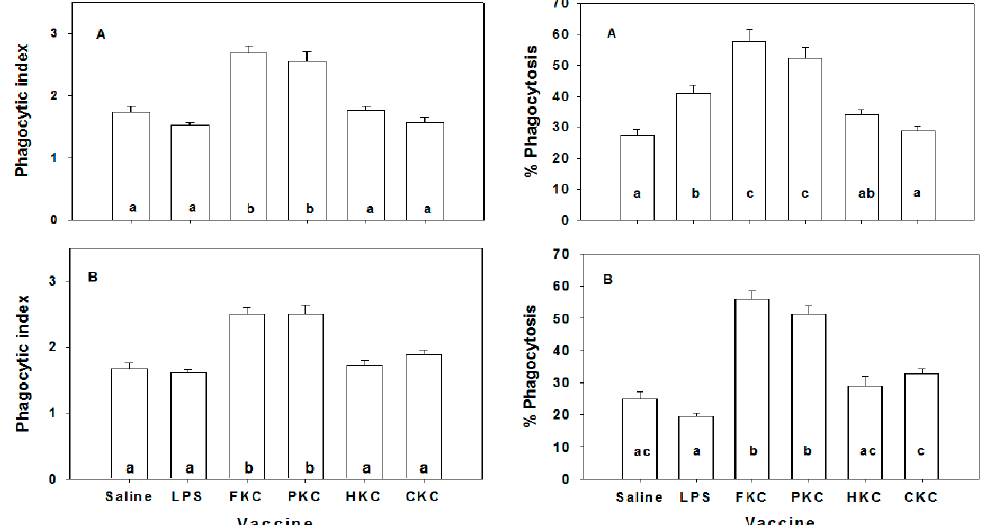
Figure 5. Phagocytic indices and percent of phagocytosis of pronephic ( A ) and splenic ( B ) macrophages of Sparus sarba immunized i.p. with various vaccines. Groups with different alphabets are significantly different ( p < 0.05) from each other. LPS: lipopolysaccharides; FKC: formalin killed cells; PKC: phenol killed cells; HKC: heat killed cells; CKC: chloroform killed cells.